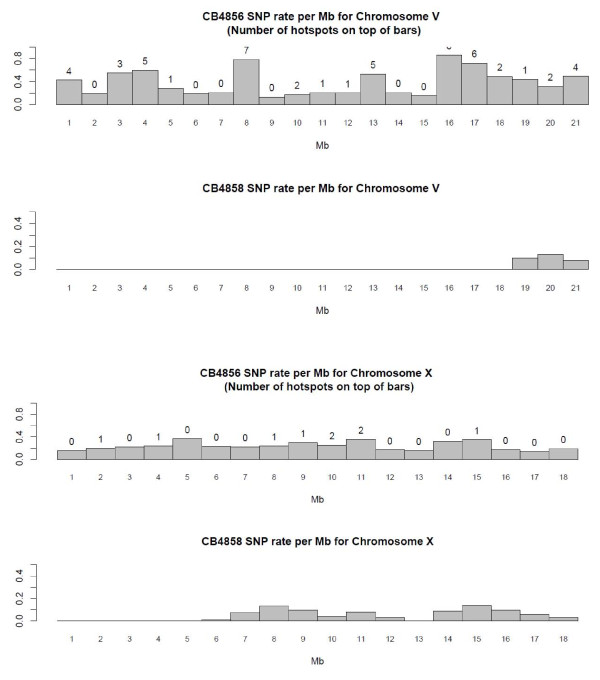
SNP rate per Mb for Chromosomes V and X in CB4856 and CB4858.